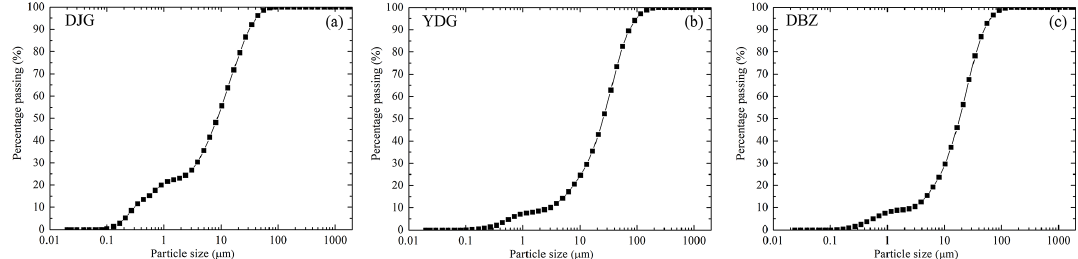
Figure 2. Particle size distribution curves. (a) Particle size distribution curve of soil obtained from DJG. (b) Particle size distribution curve of soil obtained from YDG. (c) Particle size distribution curve of soil obtained from DBZ.